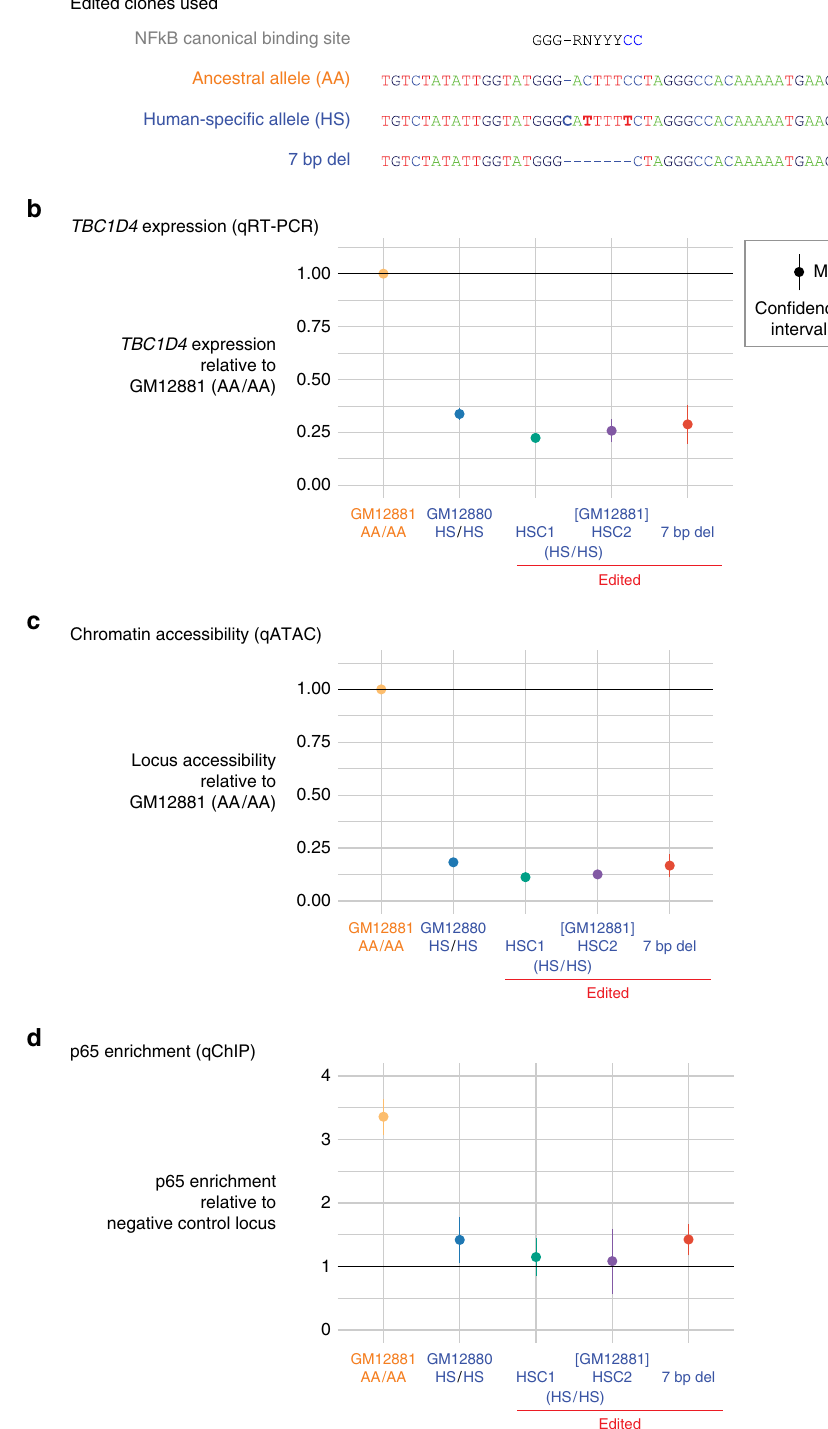
Fig. 9 Allelic editing leads to local functional changes among edited clones. In a we show the ancestral and human-speci fi c alleles, and a 7 bp deletion that was also generated by CRISPR-Cas9 editing. In b TBC1D4 gene expression levels are shown in the unedited GM12881 (AA/AA) and GM12880 (HS/HS) LCLs, compared with two human-speci fi c clones (HSC1, HSC1) and the 7 bp deletion clone generated from GM12881 ( n = 3 independent experiments each). As expected, there is a strong decrease in expression of TBC1D4 in the HS/HS GM12880 LCL compared with AA/AA GM12881, while the edited HSC1, HSC2, and 7 bp deletion clones show levels of expression comparable with the HS/HS unedited control. In c we show that this editing is associated with a decrease in chromatin accessibility ( n = 3 independent experiments each), and in d with a decrease in the p65 component of NF κ B using quantitative ChIP ( n = 3 independent experiments each). Source data are provided in a Source Data fi